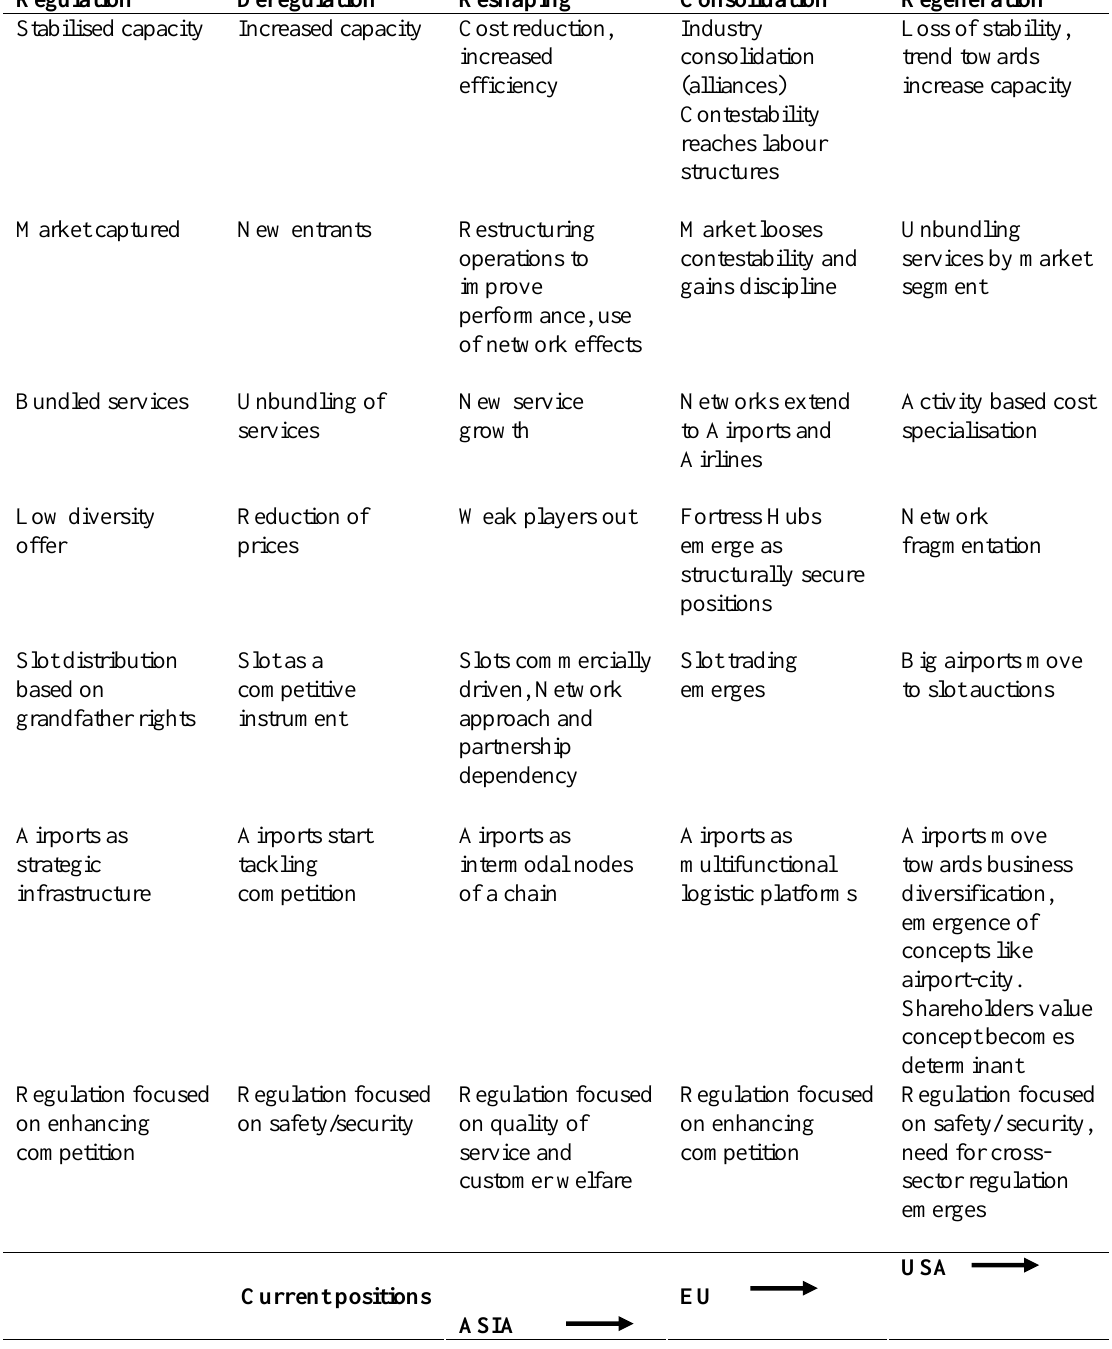
Table 2. Features of the different evolutionary phases of air transport industry